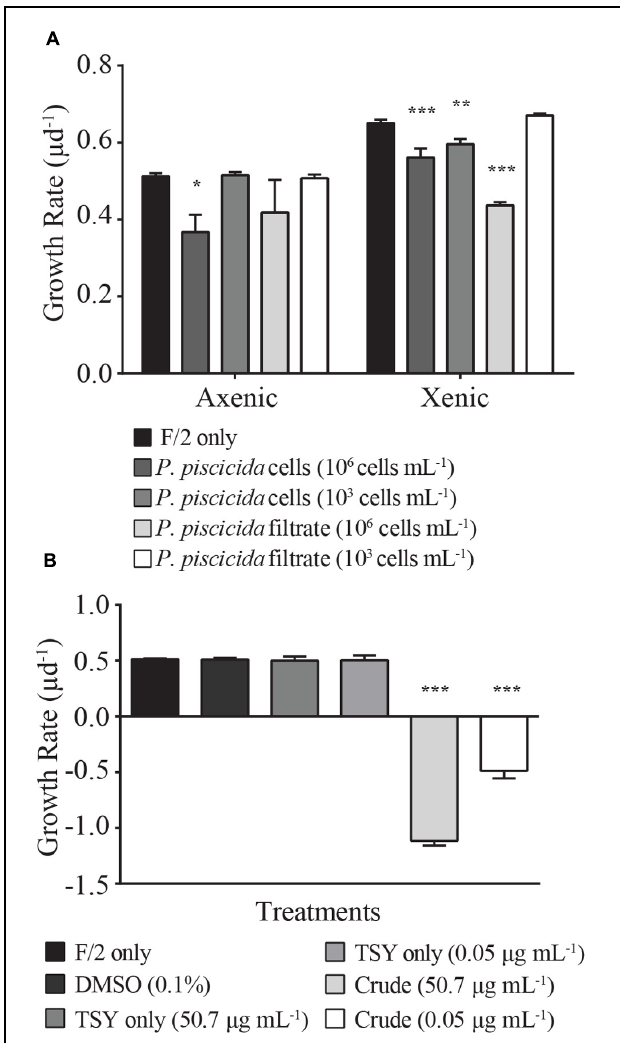
FIGURE 1 | Growth rates ( µ d − 1 ) of Emiliania huxleyi (strain 624, either xenic or axenic) were measured in response to (A) live Pseudoalteromonas piscicida cells and filtrate. Growth rates ( μ d − 1 ) of axenic E. huxleyi (strain 624) were measured in response to (B) crude extracts of P. piscicida secreted metabolites and appropriate media (F/2 and TSY) and solvent (DMSO) controls. Compared to the control, the growth rate of E. huxleyi significantly decreased in response to high concentrations (10 6 cells mL − 1 ) of P. piscicida and the crude extracts. Additionally, high concentrations of culture filtrate and low concentrations (10 3 cells mL − 1 ) of P. piscicida resulted in a significant decrease in E. huxleyi growth but only in the xenic subculture. Significance is denoted as being less than 0.05 ( ∗ ), less than 0.01 ( ∗∗ ), or less than 0.001 ( ∗∗∗ ). For all treatments, n = 3. All error bars are one standard deviation of the